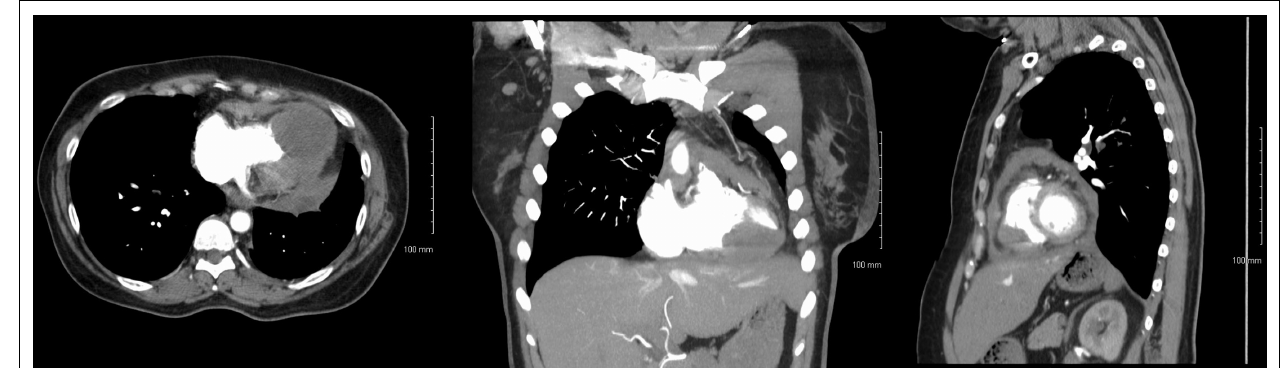
FIGURE 1 | Axial (left), coronal (center), and sagittal (right) CT with contrast images showing intracardiac metastasis .